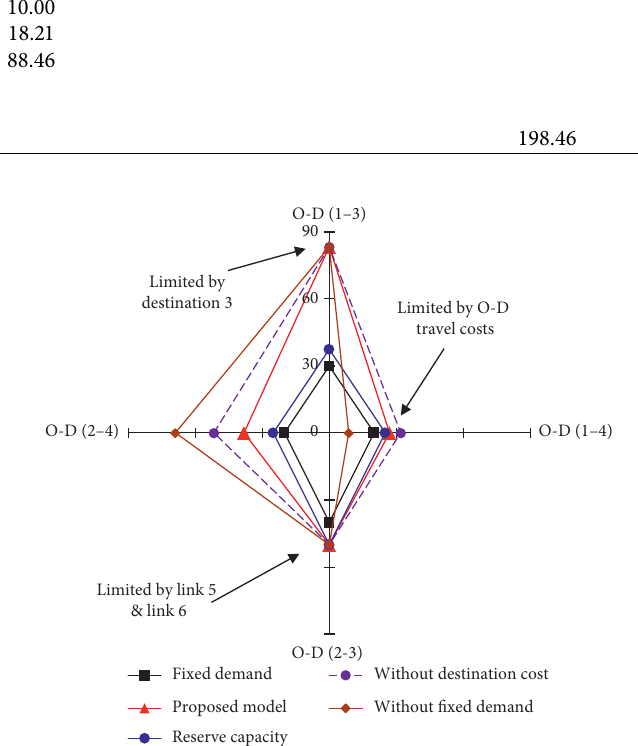
Figure 2: O-D demand pattern of maximum flow from different network capacity